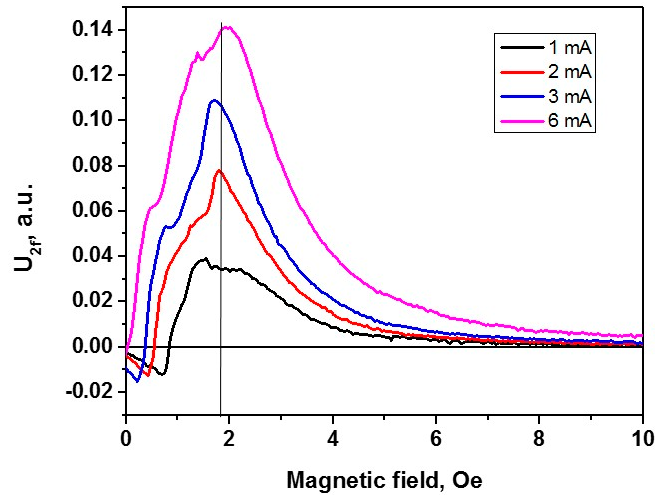
Figure 5. AMR curves for the alternating current amplitudes of 1 mA, 2 mA, 3 mA, and 6 mA. The AMR curves obtained for the alternating current amplitude of 2 mA ( h φ = 0.3)